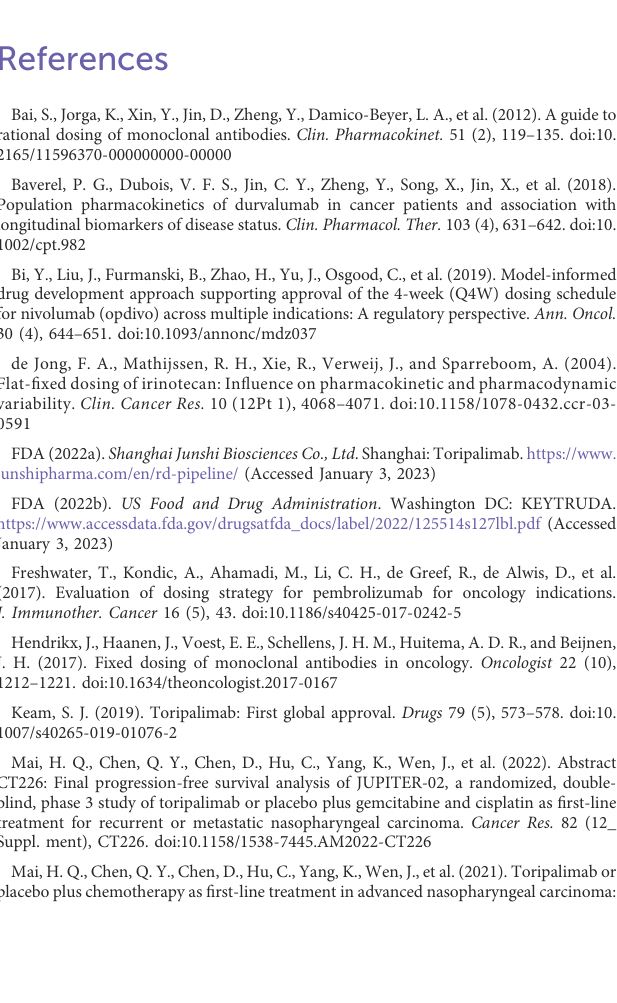
SUPPLEMENTARY FIGURE S1 Toripalimab binds with PD-1 expressed on the surface of human activated T cells. Note: Y-axis represents the percentage of receptor occupancy on activated CD4+ and CD8+ T cells in four donors. X-axis represents aseries of toripalimab concentrations. Supplementary Figure S1 (A) , (B) , (C) , and (D) represent four different donors. Abbreviations: EC50, half-maximal effective concentration. SUPPLEMENTARY FIGURE S2 Probability of adverse event exposure-response model for toripalimab monotherapy. The solid red line is the predicted probability of experiencing threedifferentcategories ofadverseevents[grade ≥ 3AEs,treatment-related grade ≥ 3 AEs, and AEs leading to study drug discontinuation]. The gray-shaded area is the 95% CI of the model prediction. Abbreviation: CI = con fi dence